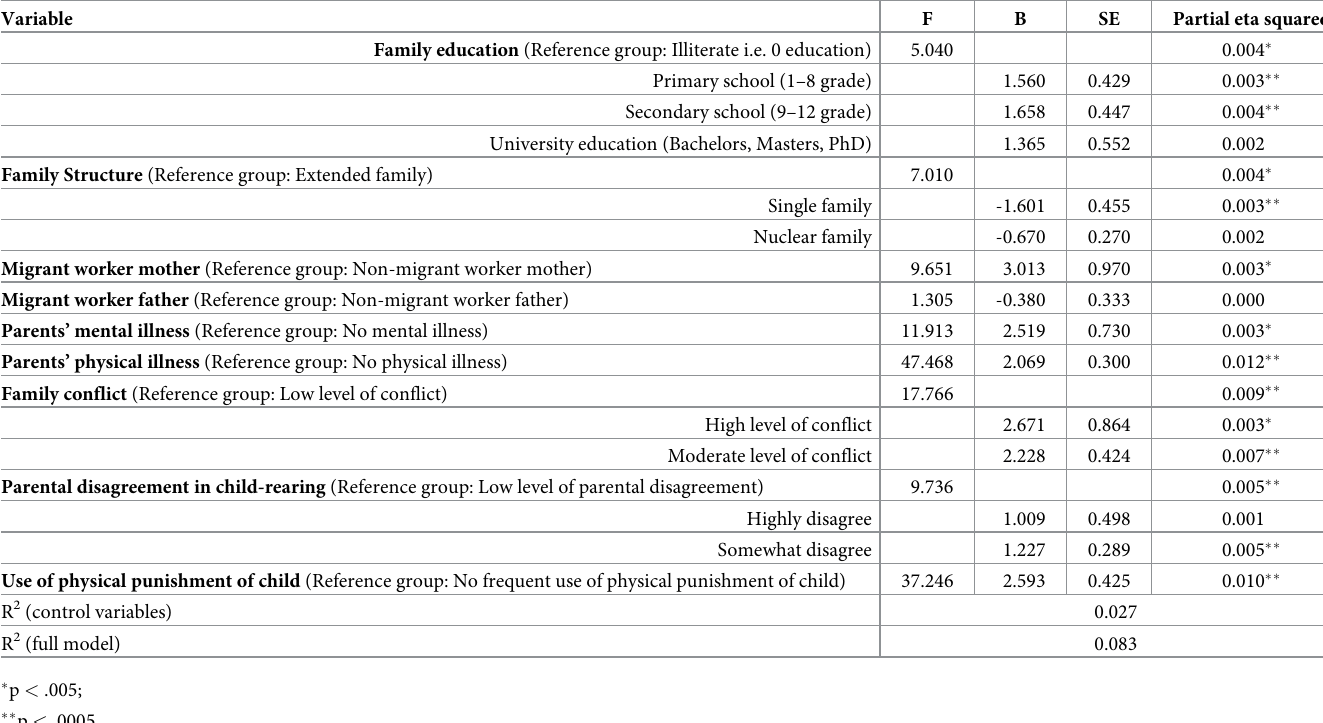
Table 4. Multiple regression analysis of associations between family factors and externalizing